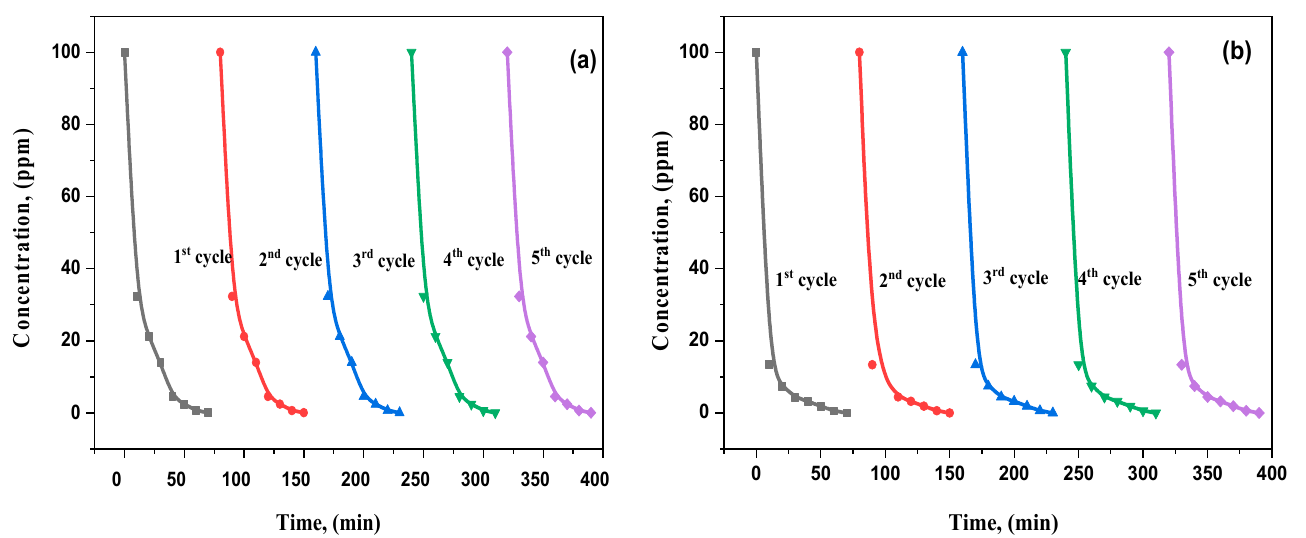
Figure 13. ( a , b ): recycling runs of (S4) La 2 O 3 -ZnO nanostructured composite for photodegradation of ( a ) MB, ( b ) RhB. of ( a ) MB, ( b )